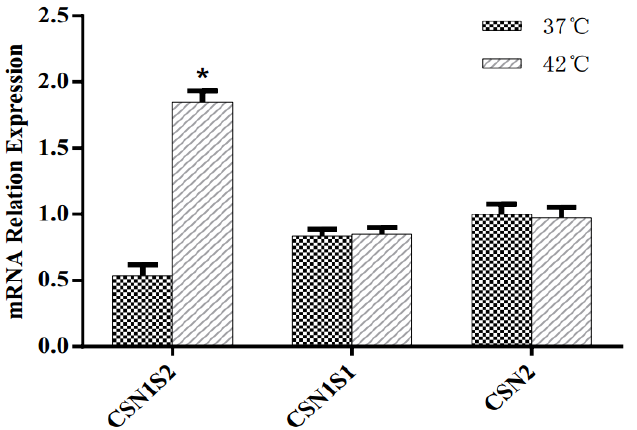
Figure 6. Effects of heat stress on mRNA expression of casein gene in immortalized bovine mammary cell lines (MAC-T) cultured at 42 ◦ C. Asterisks indicate significant differences between different groups: * p < 0.05.